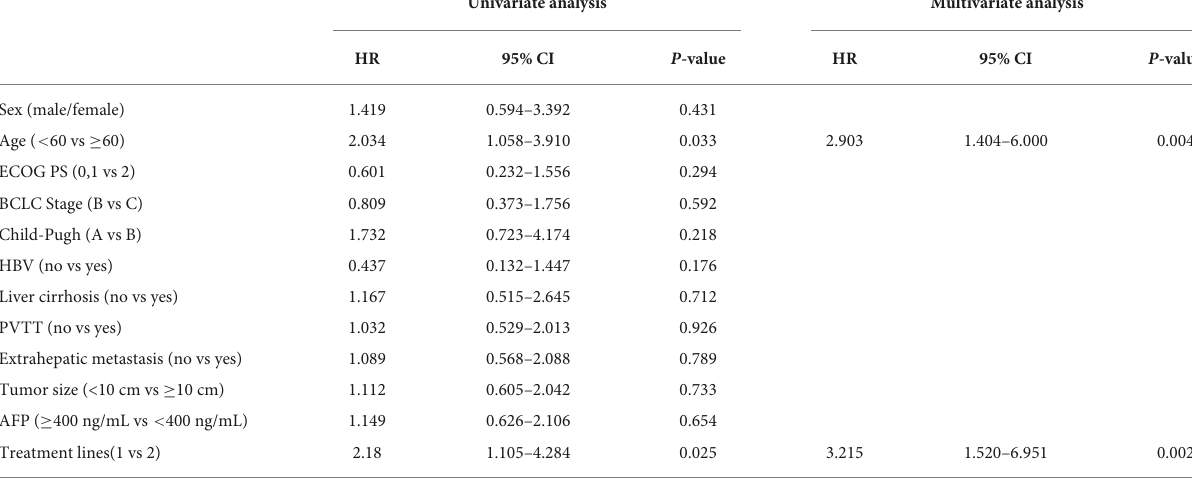
TABLE 6 Univariate and multivariate analysis of risk factors for overall survival. Univariate analysis Multivariate